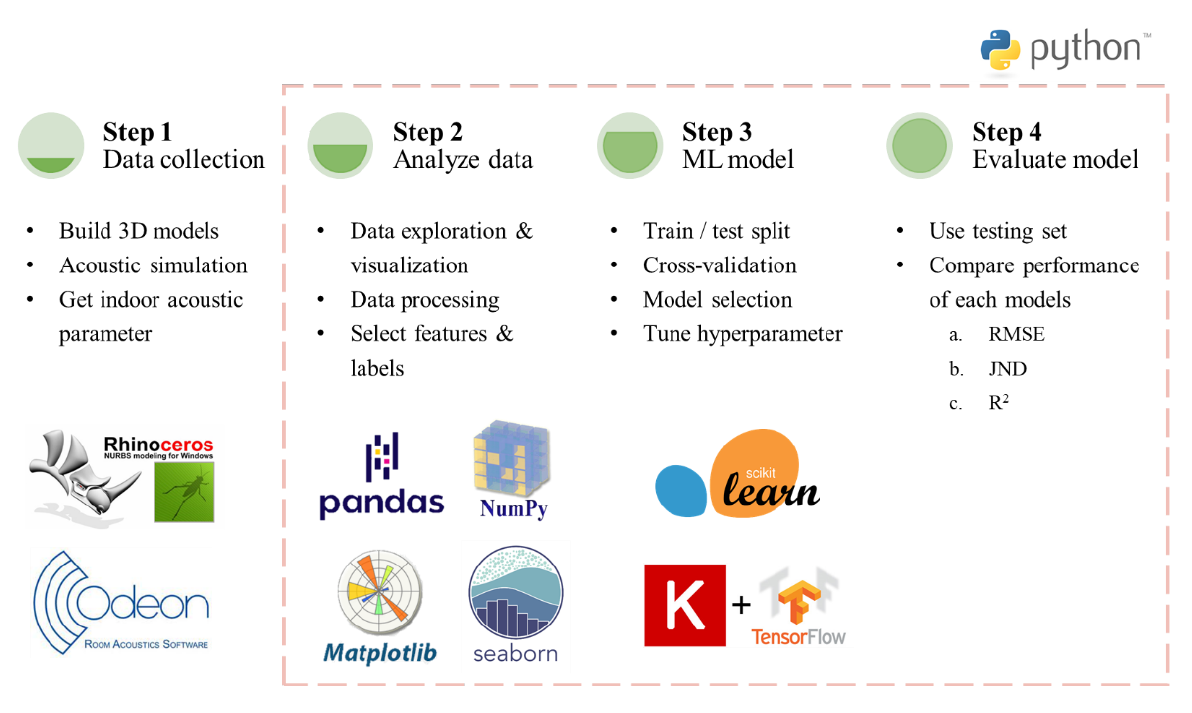
Figure 2. Boxplot of floor area of multi-functional activity centers. In accordance with ISO 3382-1 2009 [22], the room acoustic indicators are shown in Table 1. The just noticeable difference ( JND ) is the minimum amount by which stimulus intensity must be changed in order to produce a noticeable variation in sensory experi- ence. This value provides a good suggestion of the accuracy required for prediction. Less